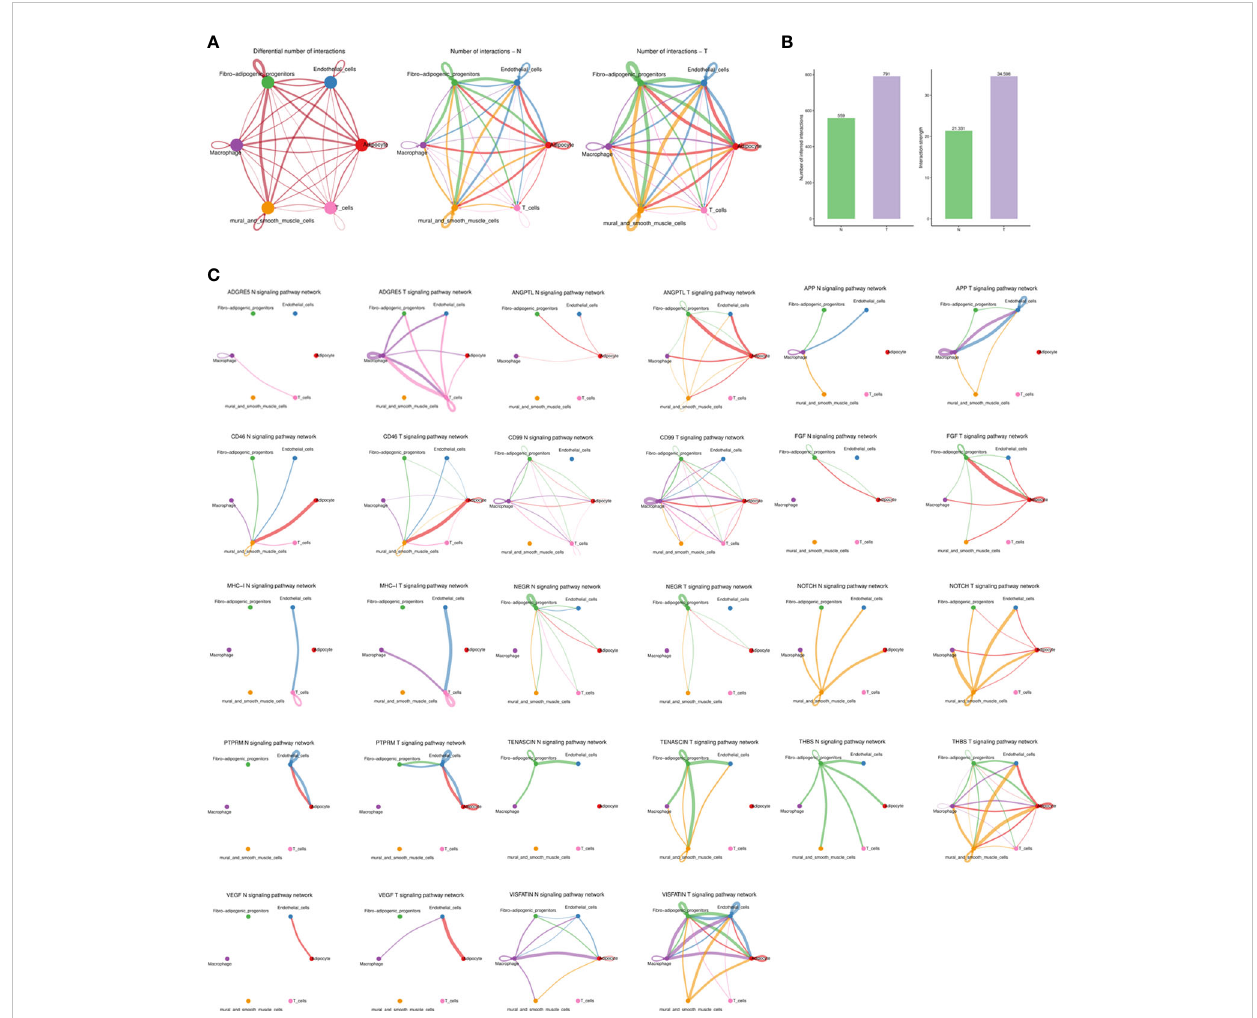
FIGURE 7 The dense network and multiple cellular communications. (A) Circos plot showing the interactions between ligands and receptors across cell types in two groups (left), N group (middle), and T group (right). Different colors in the circle plot represent different cell groups. The thicker the line is, the more interactions between cell types are detected. The color of the line is the same as that of the ligand cell, that is, the cell that sends the signal. (B) Barplot showing the number and strength of interactions across cell types in two groups. The left fi gure is the statistical histogram of the number of intercellular interactions, and the right fi gure is the statistical histogram of the intensity of intercellular interactions. The abscissa represents different groups. (C) The association of different signaling pathways among different cell types of each group. Different colors in the circle plot represent different cell groups. The fi gure can view the number of interactions between cell types under a certain signal pathway. The thicker the line is, the more interactions between cell types are detected. The color of the line is the same as that of the ligand cell, that is, the cell that sends the